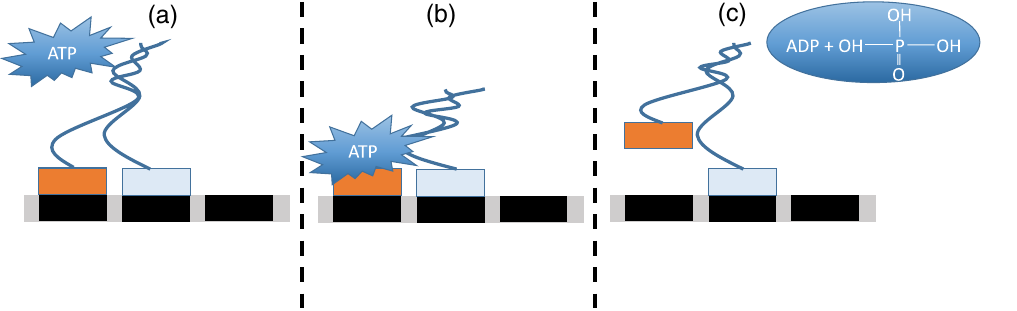
FIG. 2. The picture given to students in the kinesin task, along with a description of the kinesin ’ s